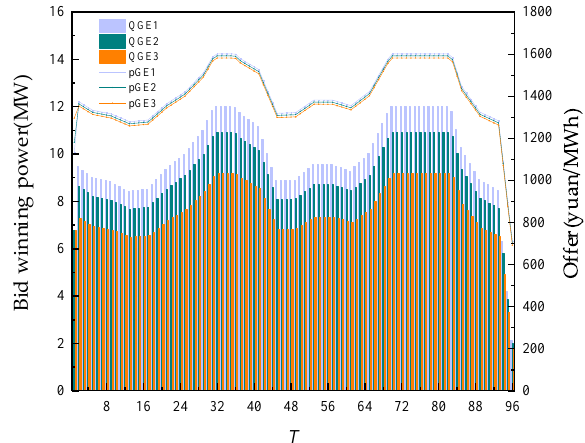
Figure 8. Day-ahead trading of thermal power units.